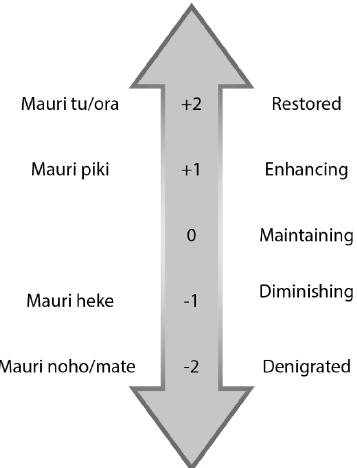
Figure 5. “ Mauri Meter” (Morgan, 2006); infographic of the valuing system in the Mauri Model. Modified from Hikuroa et al.